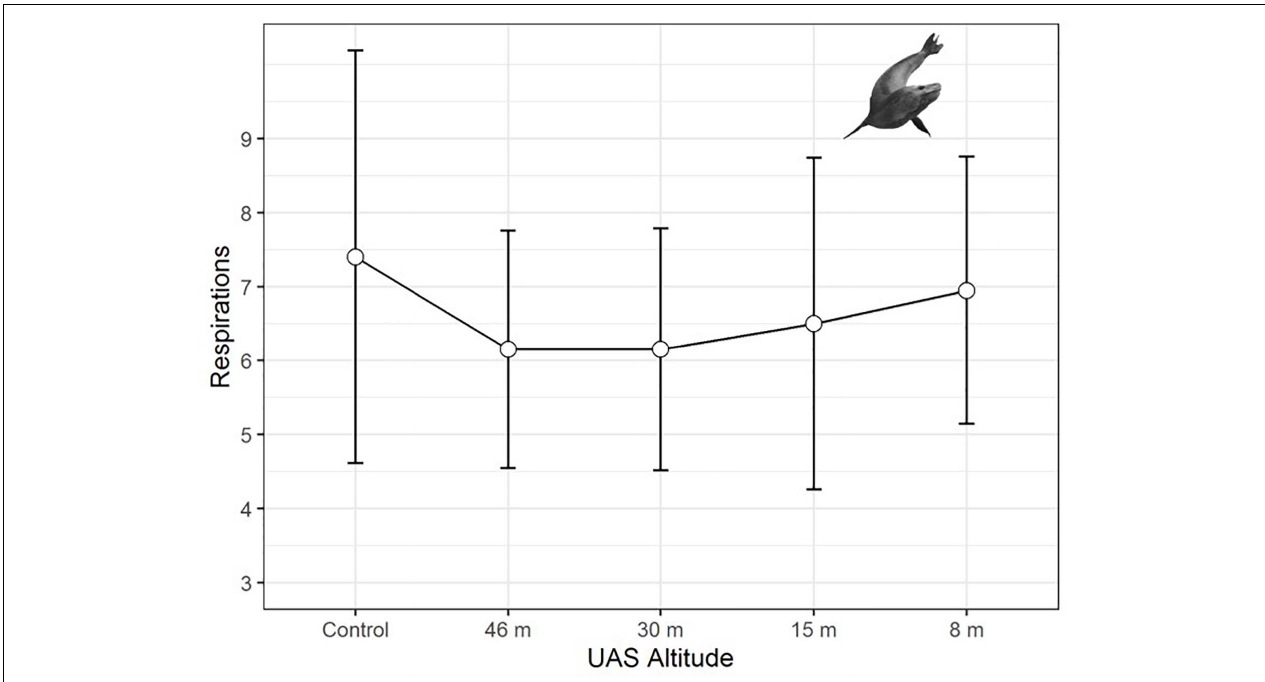
FIGURE 6 | Average respiration rates (measured in breaths per minute, plotted with standard deviation error bars) of adult leopard seals (LS, n = 297 observations) during unoccupied aerial systems (UAS) overflights at specific altitudes.